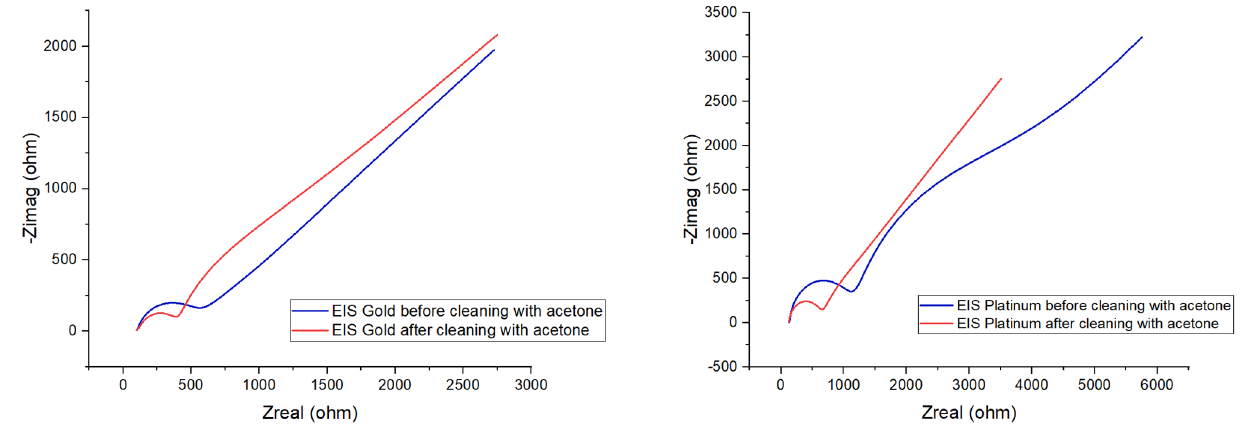
Figure 4. EIS of gold and platinum electrodes before and after cleaning with acetone: blue-EIS before cleaning; red-EIS after cleaning. Created with OriginPro.